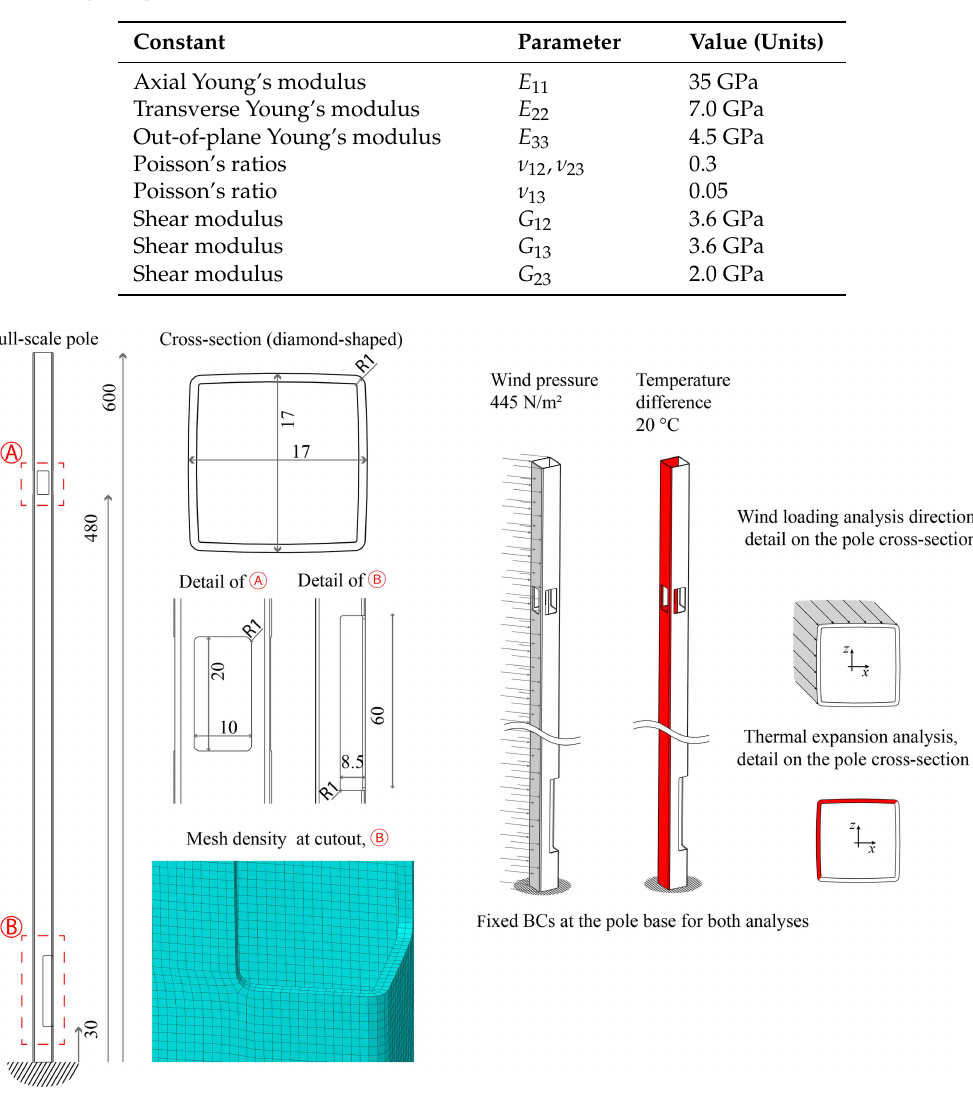
Figure 4. The dimensions (units: cm), loading, boundary conditions and mesh density applied to